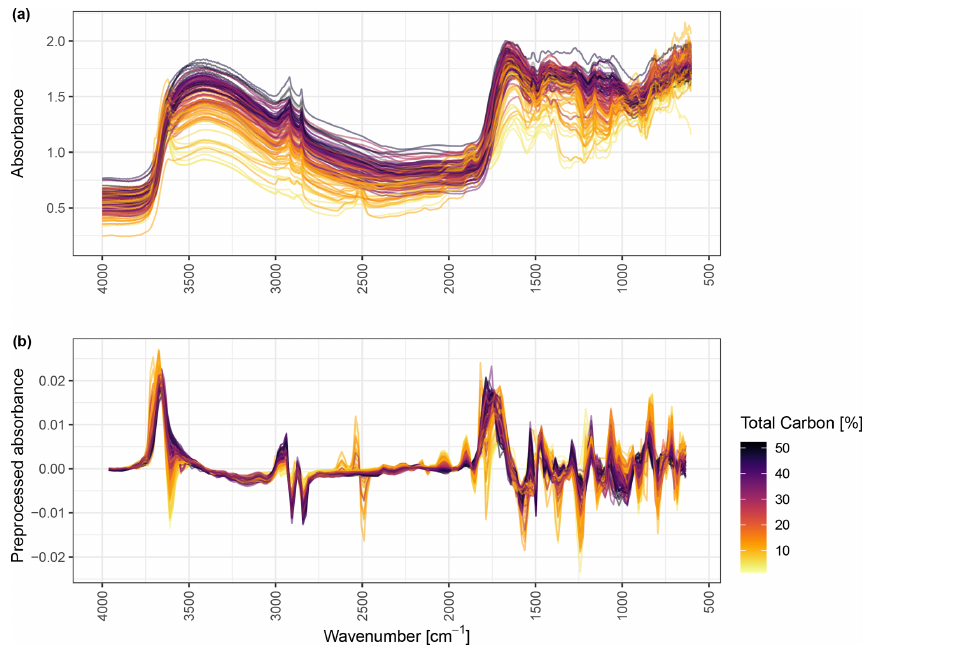
Figure 3. The raw (a) and preprocessed (b) mid-IR spectra of all the local HAFL soil samples ( n = 116) colored by total carbon content